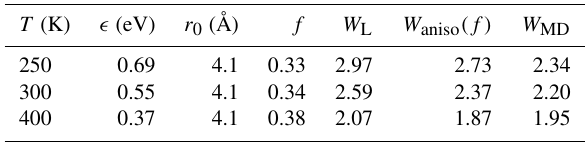
Table A1. The attractive potential parameters (cid:15) and r 0 for H 2 SO 4 – H 2 SO 4 interaction based on the PMF calculations with the es- timated anisotropic interaction factor f = U K /U and the corre- sponding enhancement factors calculated by the Langevin model W L , the anisotropic approach W aniso (f ) , and the atomistic simula- tions W MD .